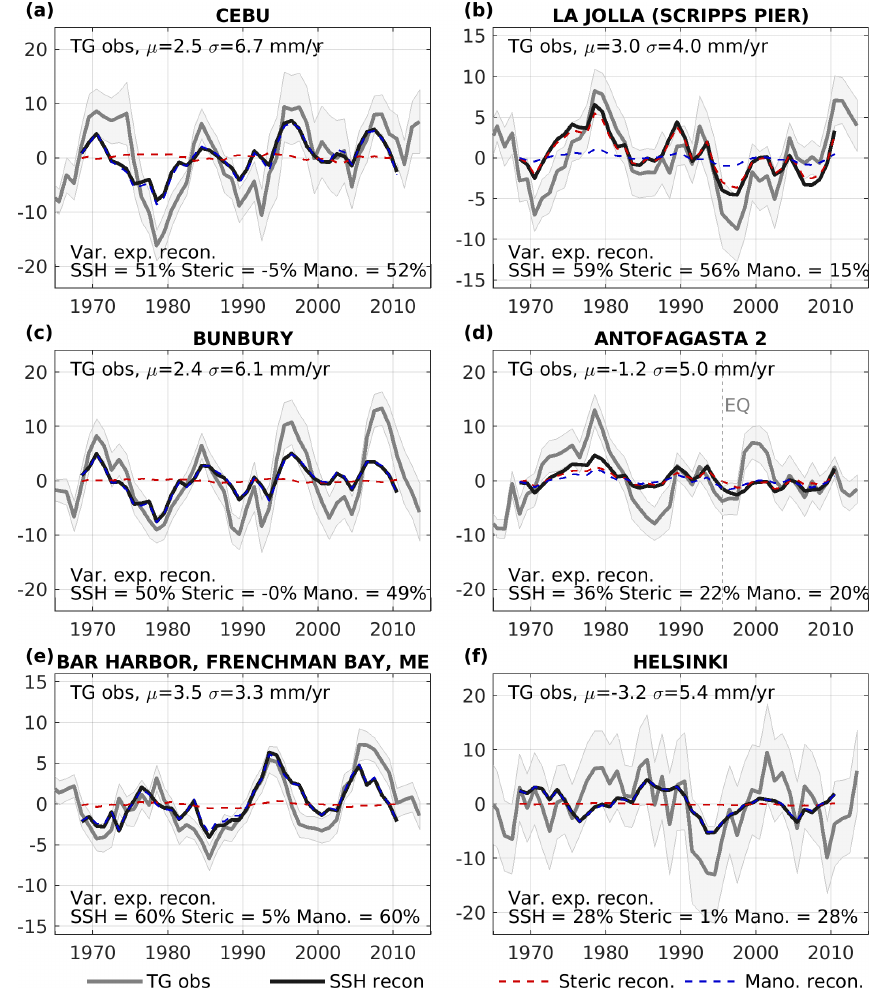
Figure 4. Observed sea-level trends in tide gauge observed sea level (mmyr − 1 ; grey solid lines, light grey shading presents 1 σ trend error estimates, triangles in Fig. 3) and the reconstructed decadal trends from all PCs for the appropriate basin for steric sea level (red dashed), manometric plus GRD sea level (blue dashed), and the sum (black solid). Note that the time mean sea-level trend is removed from all tide gauge observed data for